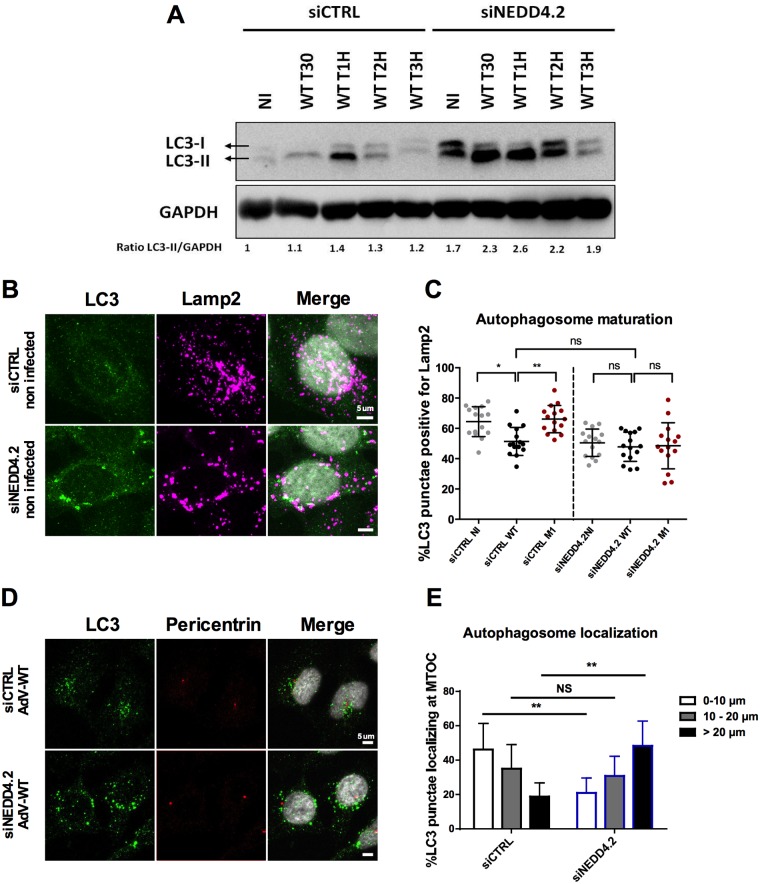
Nedd4.2 controls autophagy upon AdV infection.(A) Nedd4.2 or control depleted cells were infected with WT virus. Cell lysates were analyzed at indicated time points by western blot using LC3 and GAPDH specific antibodies as shown to the left. (NI = non infected). The ratio of LC3II/GAPDH normalized to the non-infected condition in siCTRL depleted cells was determined and is given below the panel. (B) Representative panel of confocal images from Nedd4.2 or control depleted cells (indicated to the left) stained with LC3 and Lamp2 specific antibodies. (C) Nedd4.2 or control depleted cells non-infected (NI) or infected with WT or M1 virus for 1h were fixed and stained as in (B). The percentage of LC3 and Lamp2 positive autolysosomes is indicated for each condition. (n>15 cells; NS: no significant; *: P<0.05; **: P<0.01). (D) Representative panel of confocal images from Nedd4.2 or control depleted cells infected with WT virus for 1h and stained with LC3 and pericentrin specific antibodies. (E) Quantification of the distribution of LC3 dots in cells. Localization was determined by calculating LC3 punctae distribution in concentric circles positioned around pericentrin stain as detailed in SI. The graph shows the color coded relative abundance within the 3 regions. The error bar represents cell-to-cell variation (n>15 cells; NS: no significant; **: P<0.01). (see also S6 Fig).